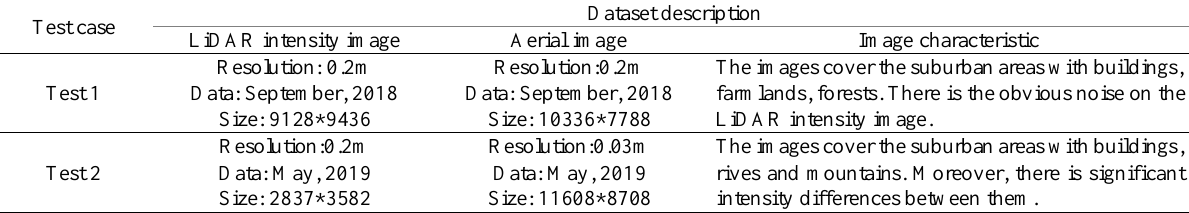
Table 1. Detailed description of test cases